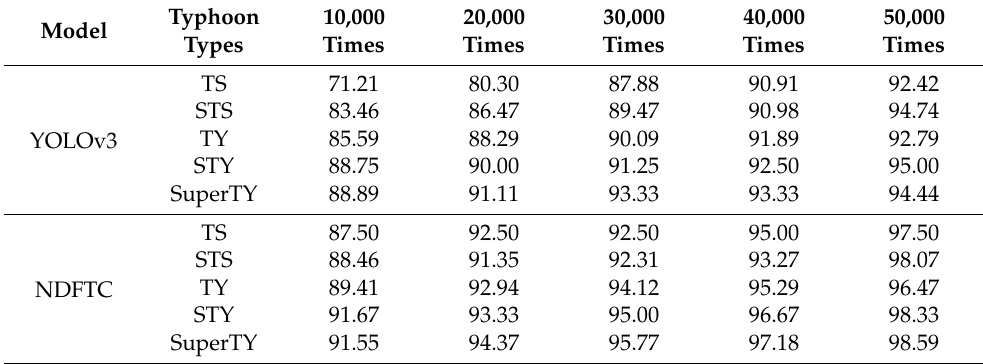
Table 1. ACC performance of the NDFTC and other models on the test set for five kinds of TCs. Model